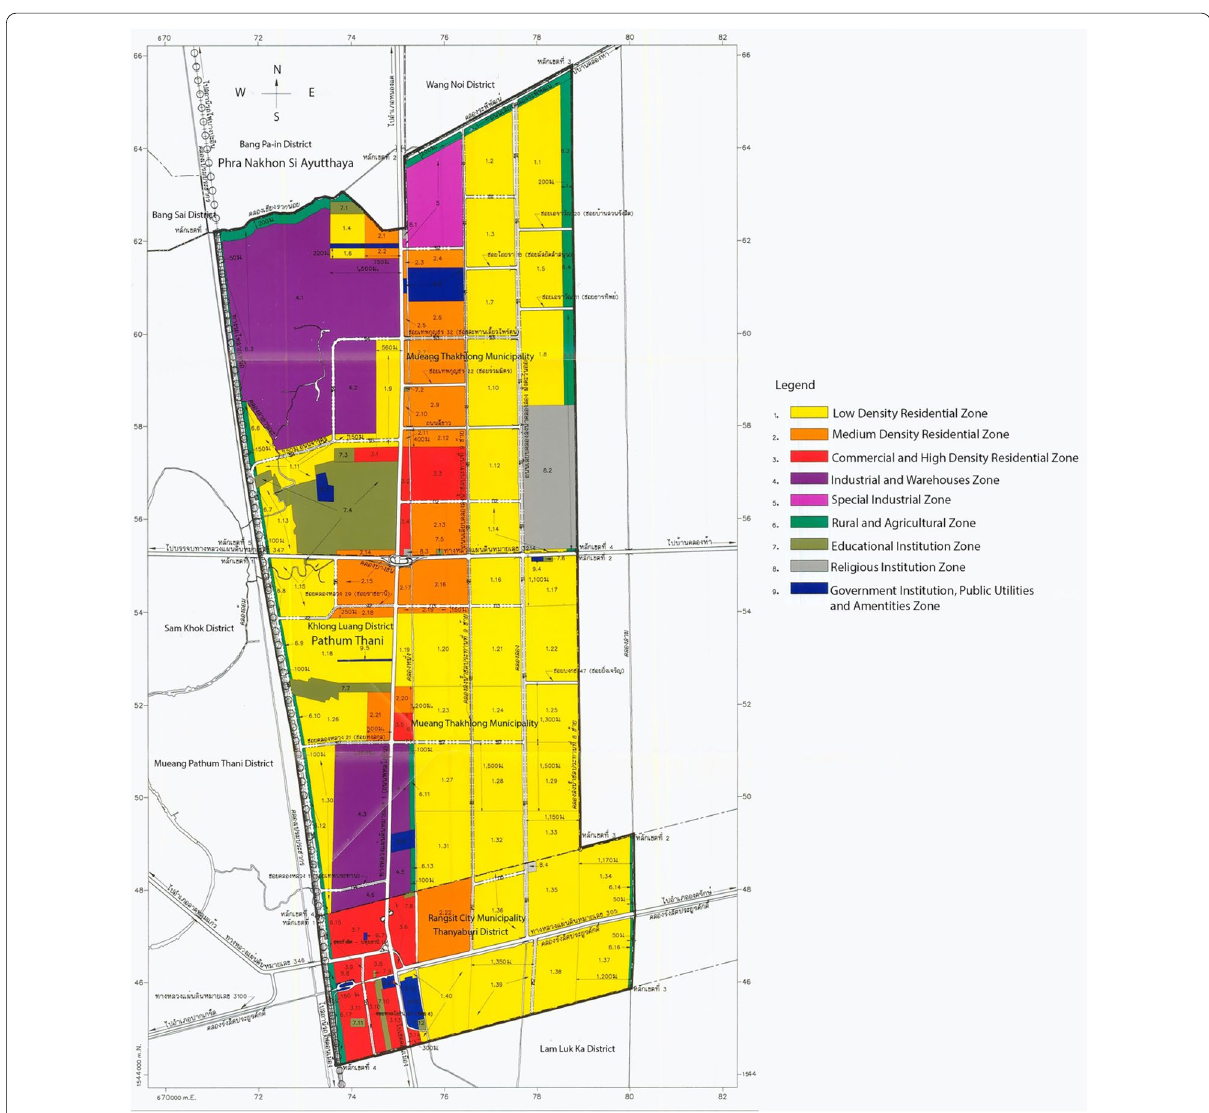
Fig. 4 The latest Comprehensive Plan of Thaklong–Klongluang in 2012 (Thailand Property Online